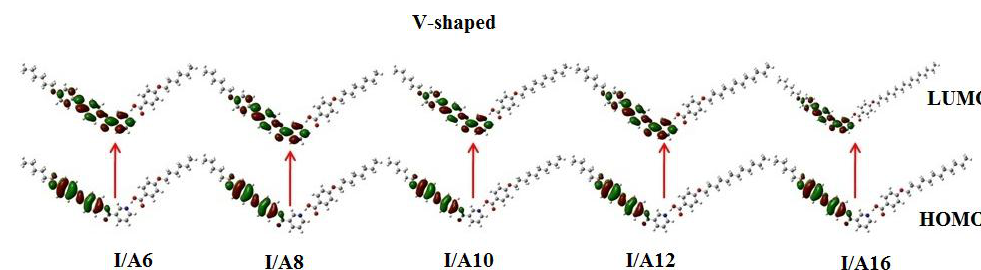
Figure 8. The estimated plots for frontier molecular orbitals of chair-shaped conformer of HBSMCs, Figure8. Theestimatedplotsforfrontiermolecularorbitalsofchair-shapedconformerofHBSMCs, I / An. I/An.